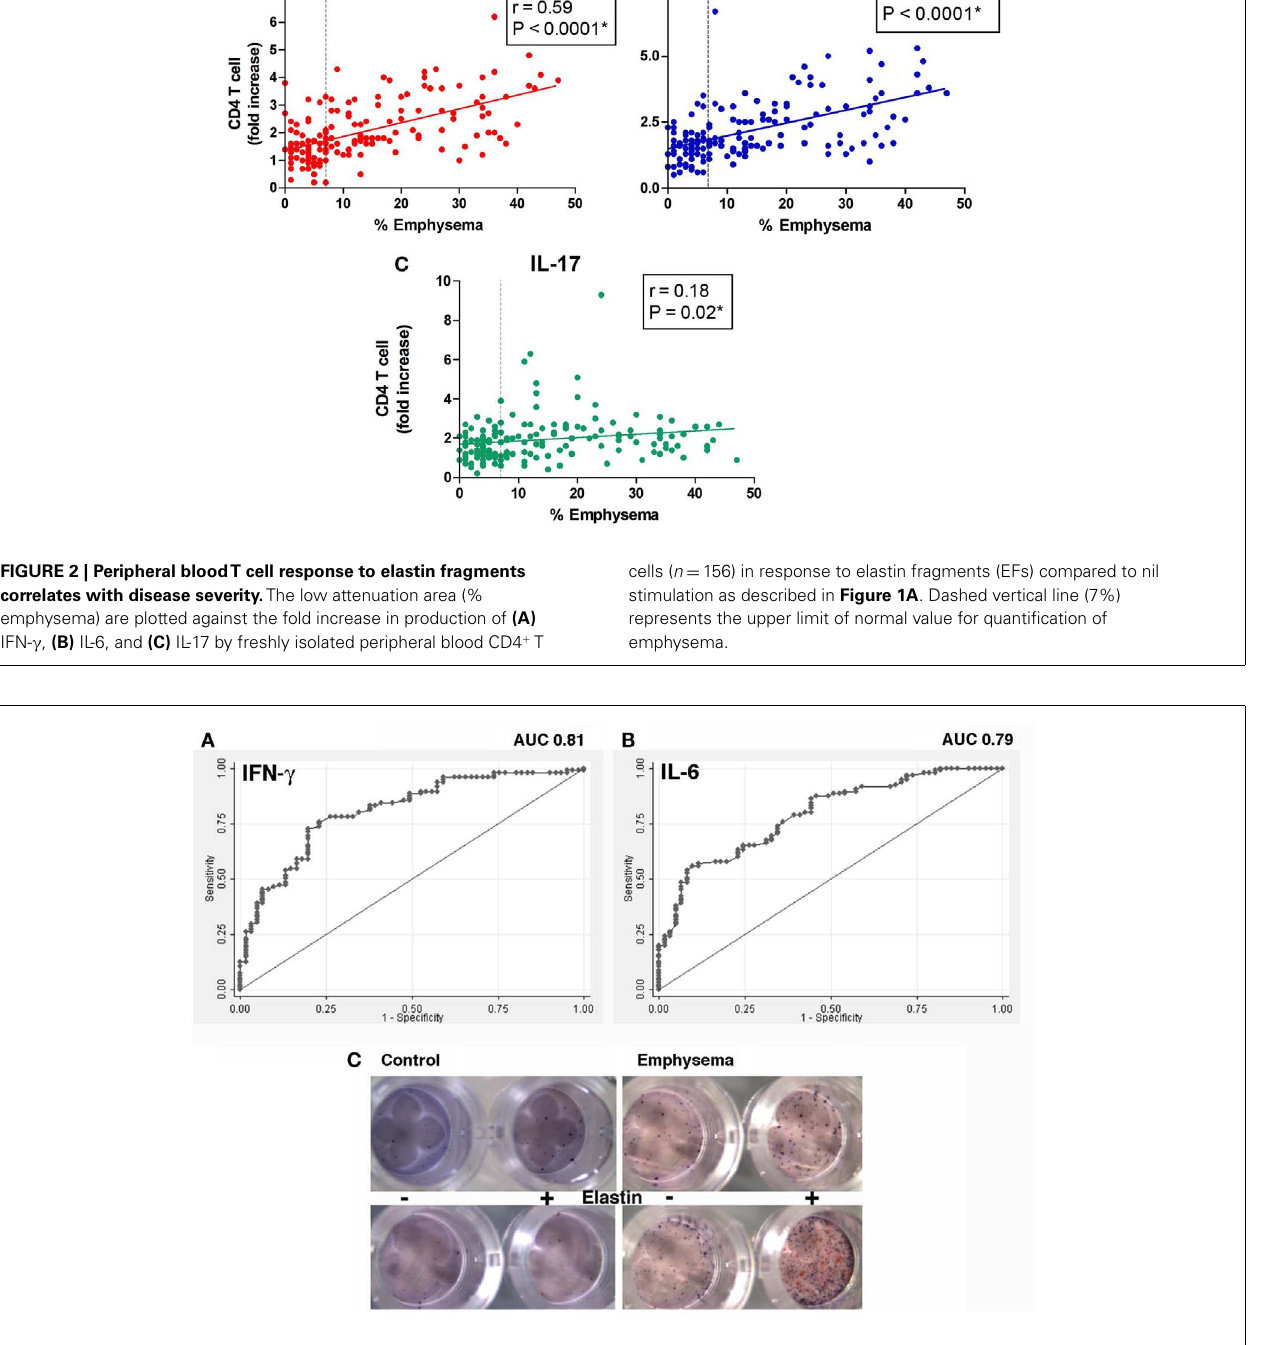
curve for IFN- γ is 0.8085 (95% CI of 0.74–0.88) and for IL-6 is 0.7912 with 95% CI of 0.72–0.86. (C) Dual color ELISpot assay showing cytokine producing cells upon elastin stimulation from four representatives. Blue and red spots indicate IL-6 and IFN- γ producingT cells,